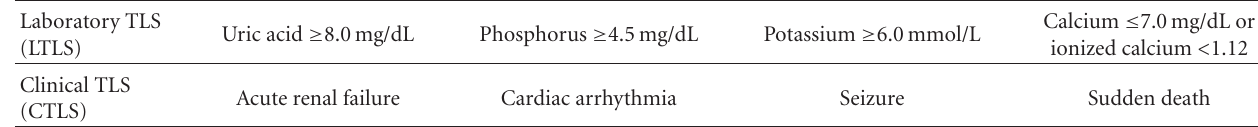
Table 3: Classification of tumor lysis syndrome by Cairo and Bishop.